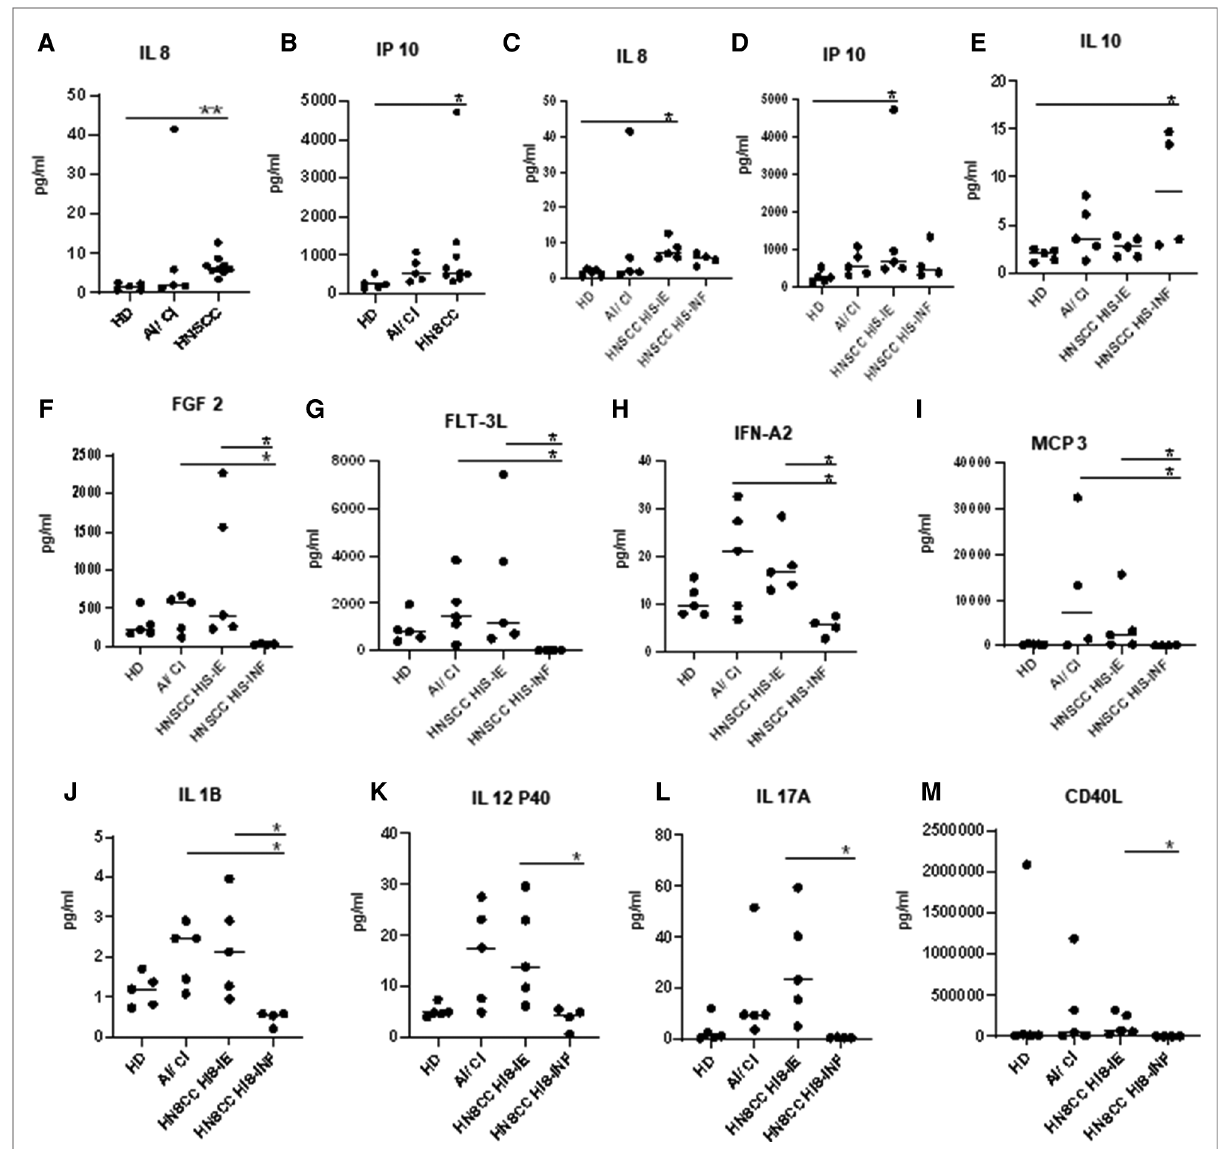
FIGURE 3 Plasma cytokine levels of HNSCC versus HD. ( A , B) Plasma cytokines demonstrating a signi fi cant difference in expression between HNSCC and HD. ( C – E ) or upon HIS strati fi cation and HD. ( F – M ) Differential cytokine expression between HIS-IE and HIS-INF. Multiple comparison analysis using the Kruskal – Wallis